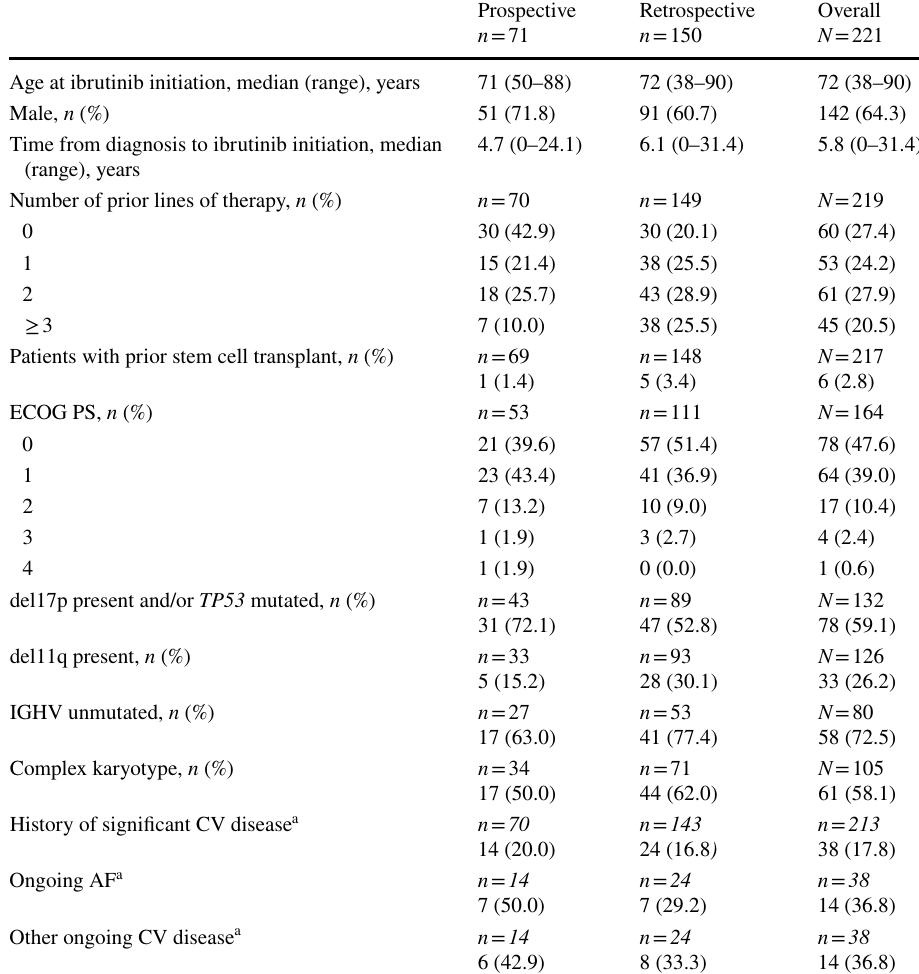
characteristics for CLL